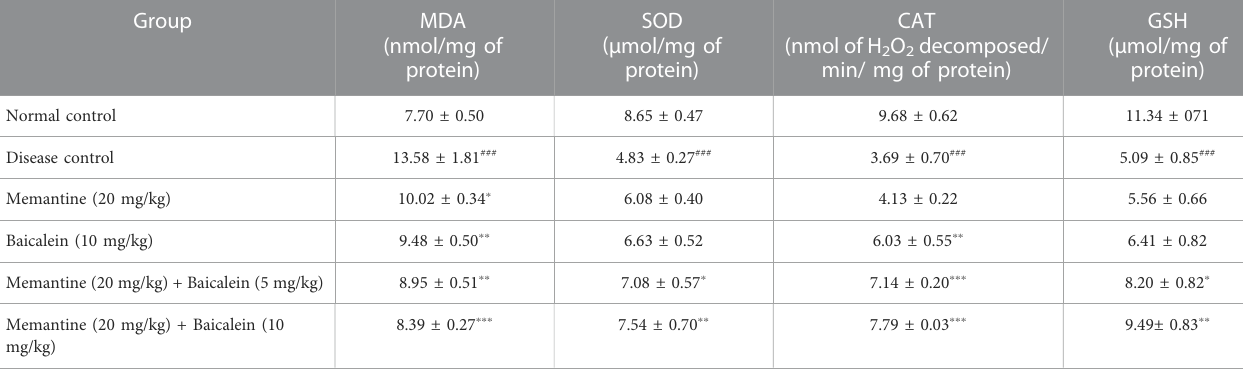
TABLE 1 Effect of baicalein and baicalein with memantine on oxidative stress parameters in hippocampus. Group